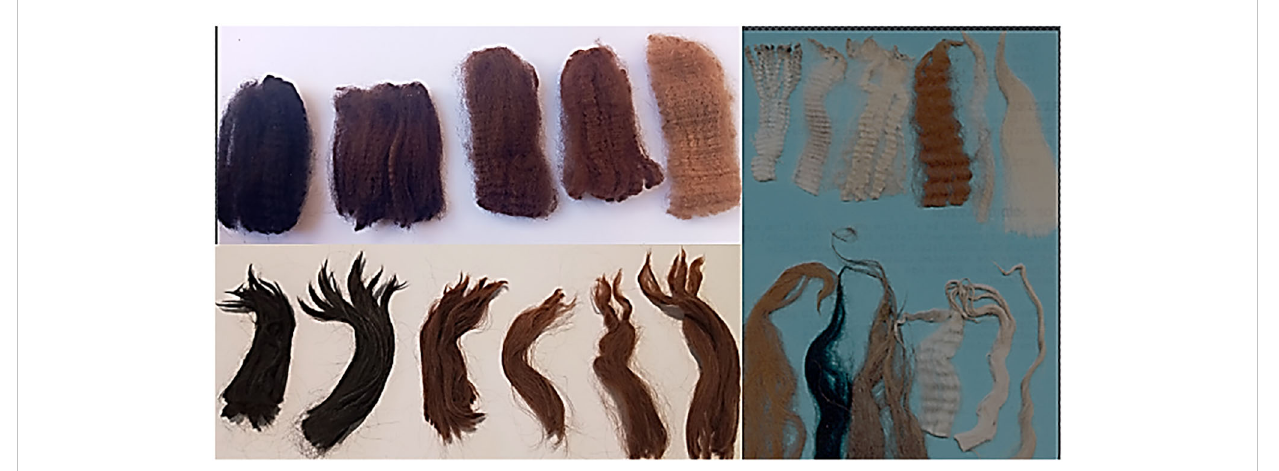
No signi fi cant double interactions of the fi ve factors analyzed (color, breed, location, age, and sex) were observed in the fi ber characteristics, except there was a signi fi cant interaction between breed and age on the mean staple length ± standard error. The Huacaya and Suri alpacas (at the milk teeth age stage) have similar staple lengths (Figure 5). MFD has a high and signi fi cant positive correlation (0.99; p < 0.001) with the spinning fi neness (Table 3) and with the SD of MFD (0.90; p < 0.001). The SD of MFD correlates positively with SF (0.94) and negatively with CF ( – 0.89). A negative correlation between MFD and CU ( – 0.46) indicates that, as fi bers get thicker, the mean curvature decreases, or vice versa. Staple length (SL) has a positive correlation with DFD, CV of MFD, and CU; however, SL is not correlated with MFD, SD, and SF.